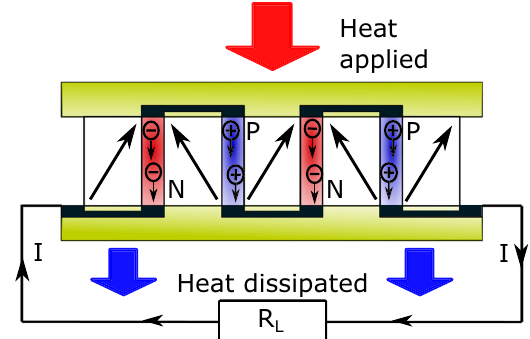
Fig. 7 Proposed design of the nano-thermoelectric device based on domain walls. White regions represent domains with different polarization orientations, acting as electrical insulators. Head-to- head and tail-to-tail domain walls, shown by red and blue regions, act as an n-type and p-type leg of the thermoelectric device, respectively. Electrodes and insulating parts are shown in black and green, respectively. Heating up the top electrodes causes electron and hole diffusion in n-type and p-type domain walls, respectively, which produces electrical